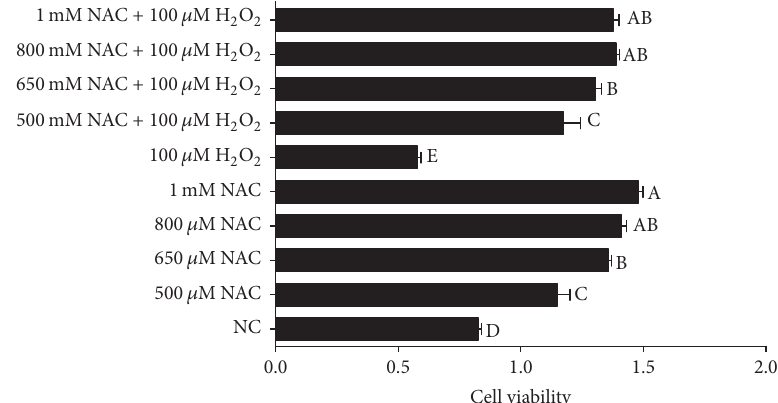
Figure 1: Cell proliferation in IPEC-J2 cells. Cells were treated with 0 (NC) to 1000 𝜇 M NAC and 0 or 100 𝜇 M H 2 O 2 , respectively, for a 2-day period. Cell viability was quantified by CCK-8 assay. Data are expressed as means ± SEM of at least three independent experiments. a–e Values with different letters are significantly different ( 𝑃 < 0.05 ).